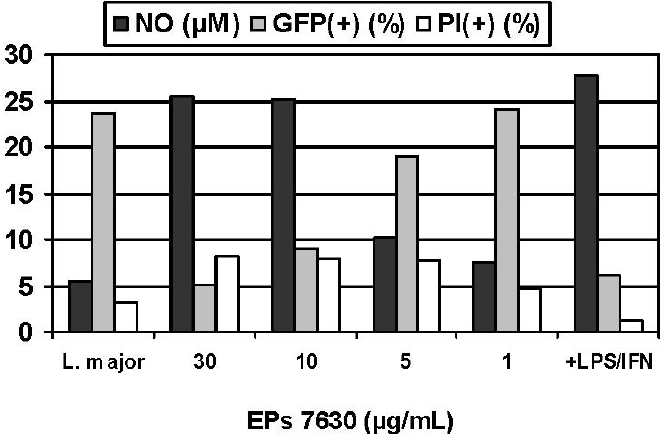
Figure 4. Immune response in L. major GFP-infected macrophages treated with EPs ® 7630: NO production (Griess assay), GFP-positive events (relative survival rates of parasites; FAS analysis), and propidium iodide-positive events (dead host cells; FACS